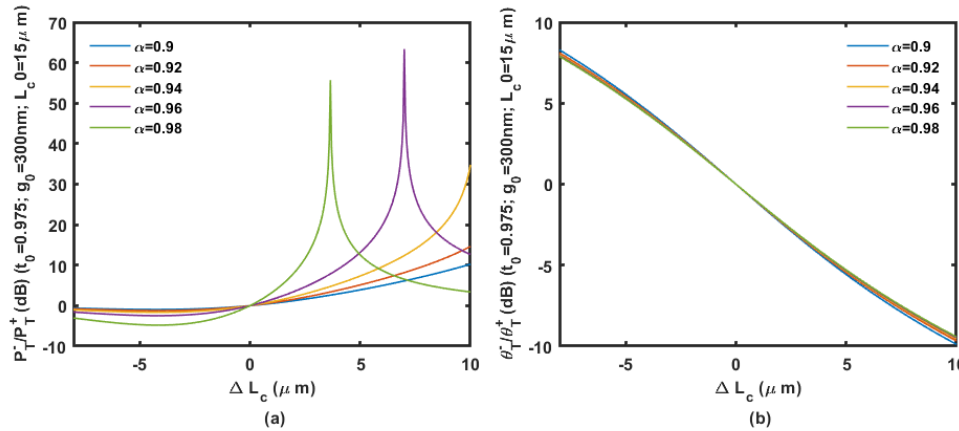
Figure 11. The power ratio ( a ) and phase ratio ( b ) according to the displacement change ∆ L c with an initial gap of 300 nm and coupling length of 15 µ m.